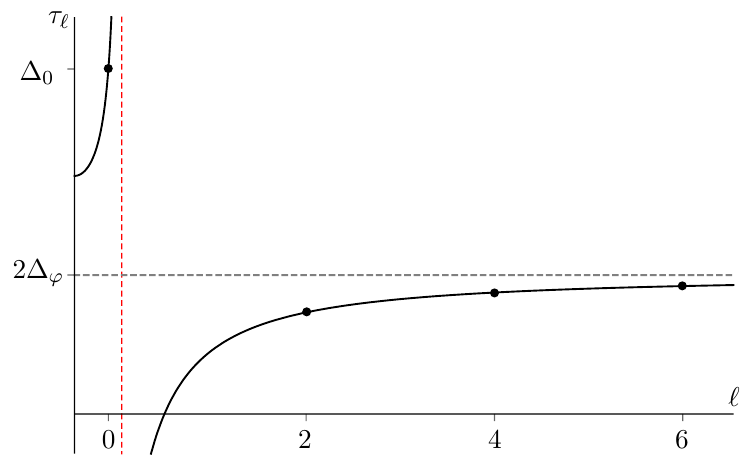
Figure 1 . Schematic graph of (cid:28) ‘ . As we move from spin two to spin zero we move to the left of the pole at (cid:22) h f = 1, denoted by a red line. Note the change of sign in the correction. Assuming the standard continuation in (2.35), we reproduce the correct dimension on both